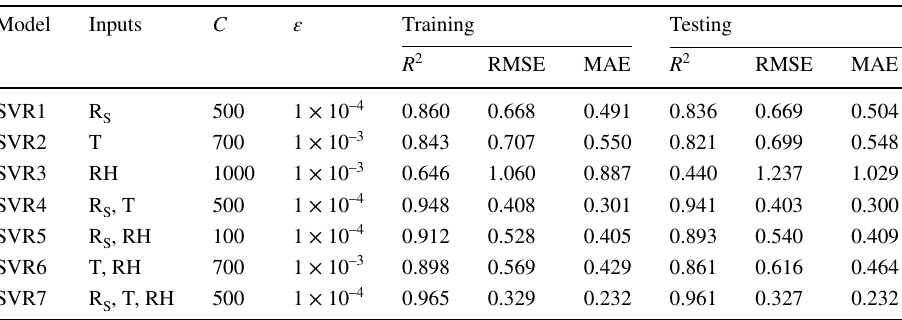
Table 3 Performance criteria obtained from the SVR models